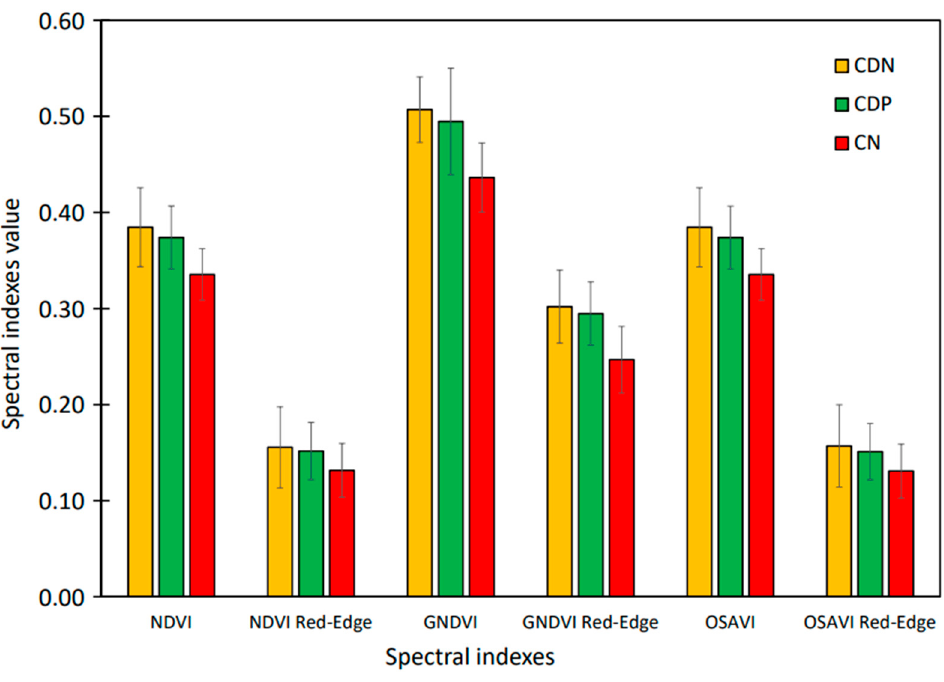
Figure 5. Distribution of the values of the spectral indices for the bioreactor analysed considering the three types of compartments: CDN, CDP, and CN.